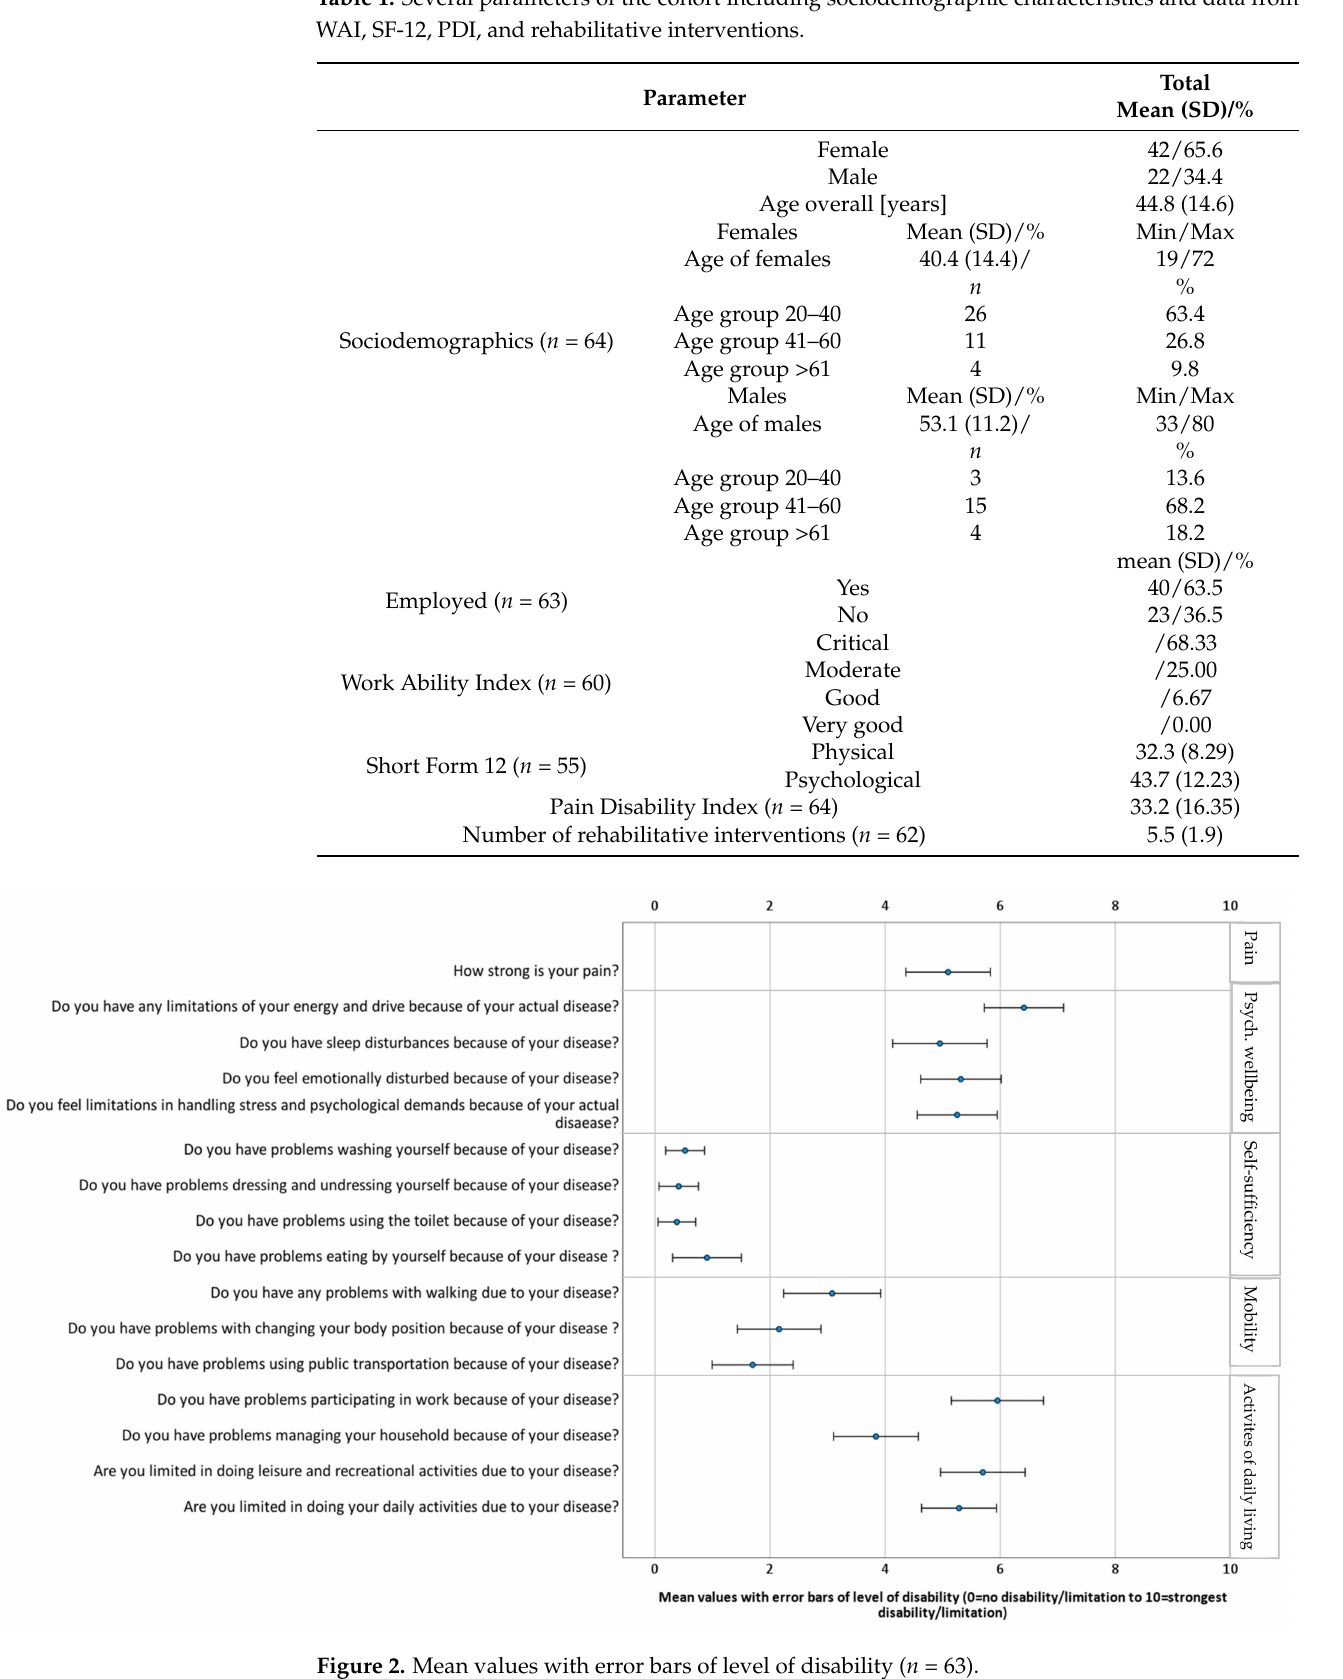
Figure 2. Mean values with error bars of level of disability ( n =